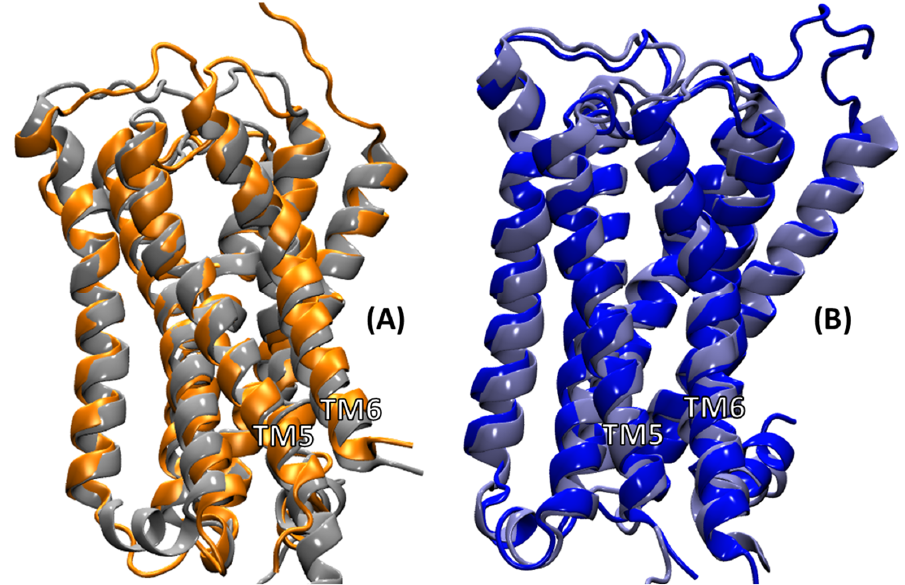
Figure 4. Overlay of the M1 and M2 receptors for the cognate complexes with the corresponding cryo-EM complexes. (A) Overlay of M1 (orange) from the average M1:Gαq molecular dynamics (MD) complex and M1 (gray) from the M1:G11 cryo-EM complex; (B) Overlay of M2 (blue) from the average M2:Gαi MD complex and M2 (gray) from the M2:Go cryo-EM complex.